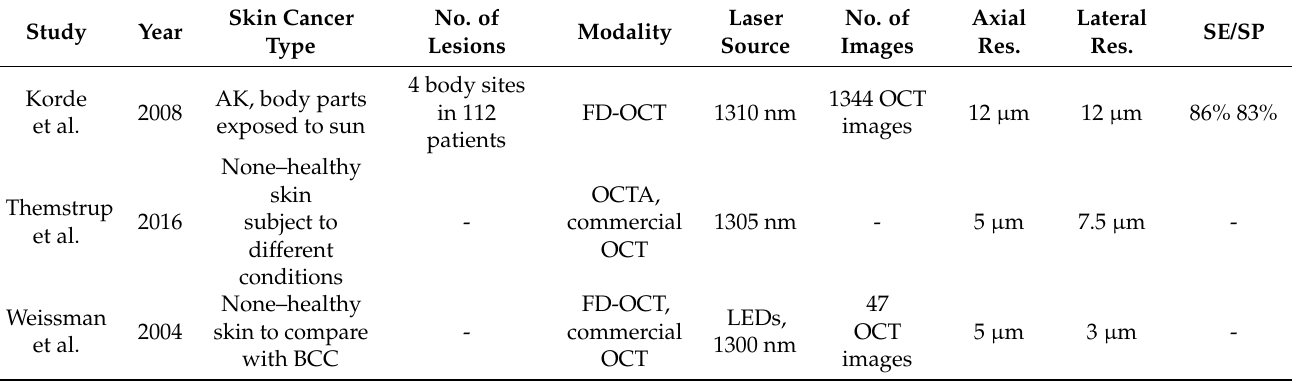
Table 4. Contributions of Optical Coherence Tomography (OCT) to skin cancer